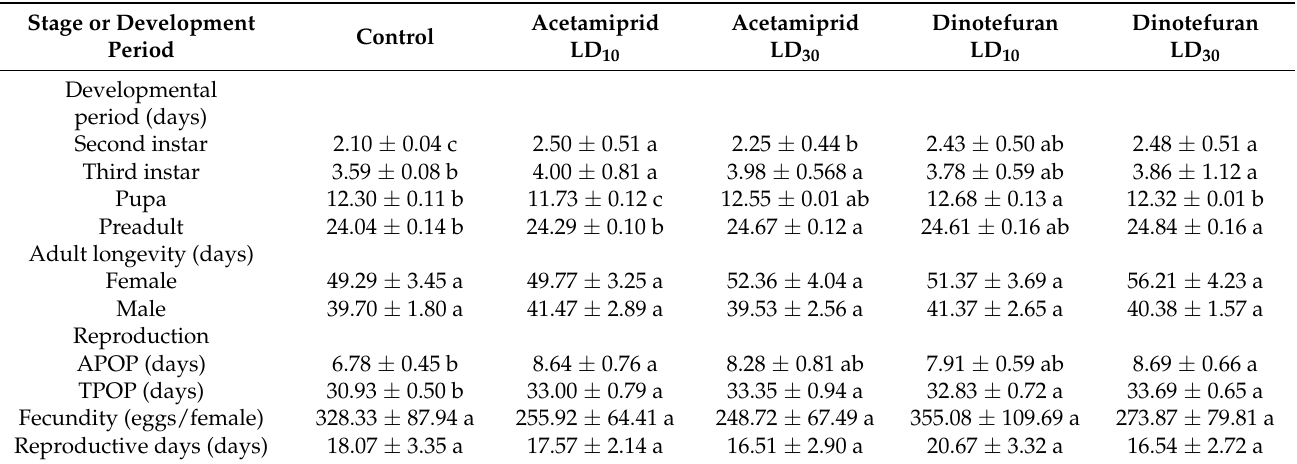
Table 2. Sublethal effects of acetamiprid and dinotefuran on development period, adult longevity, and reproduction of C. pallens adults exposed to insecticide from the 2nd instar larval stage.